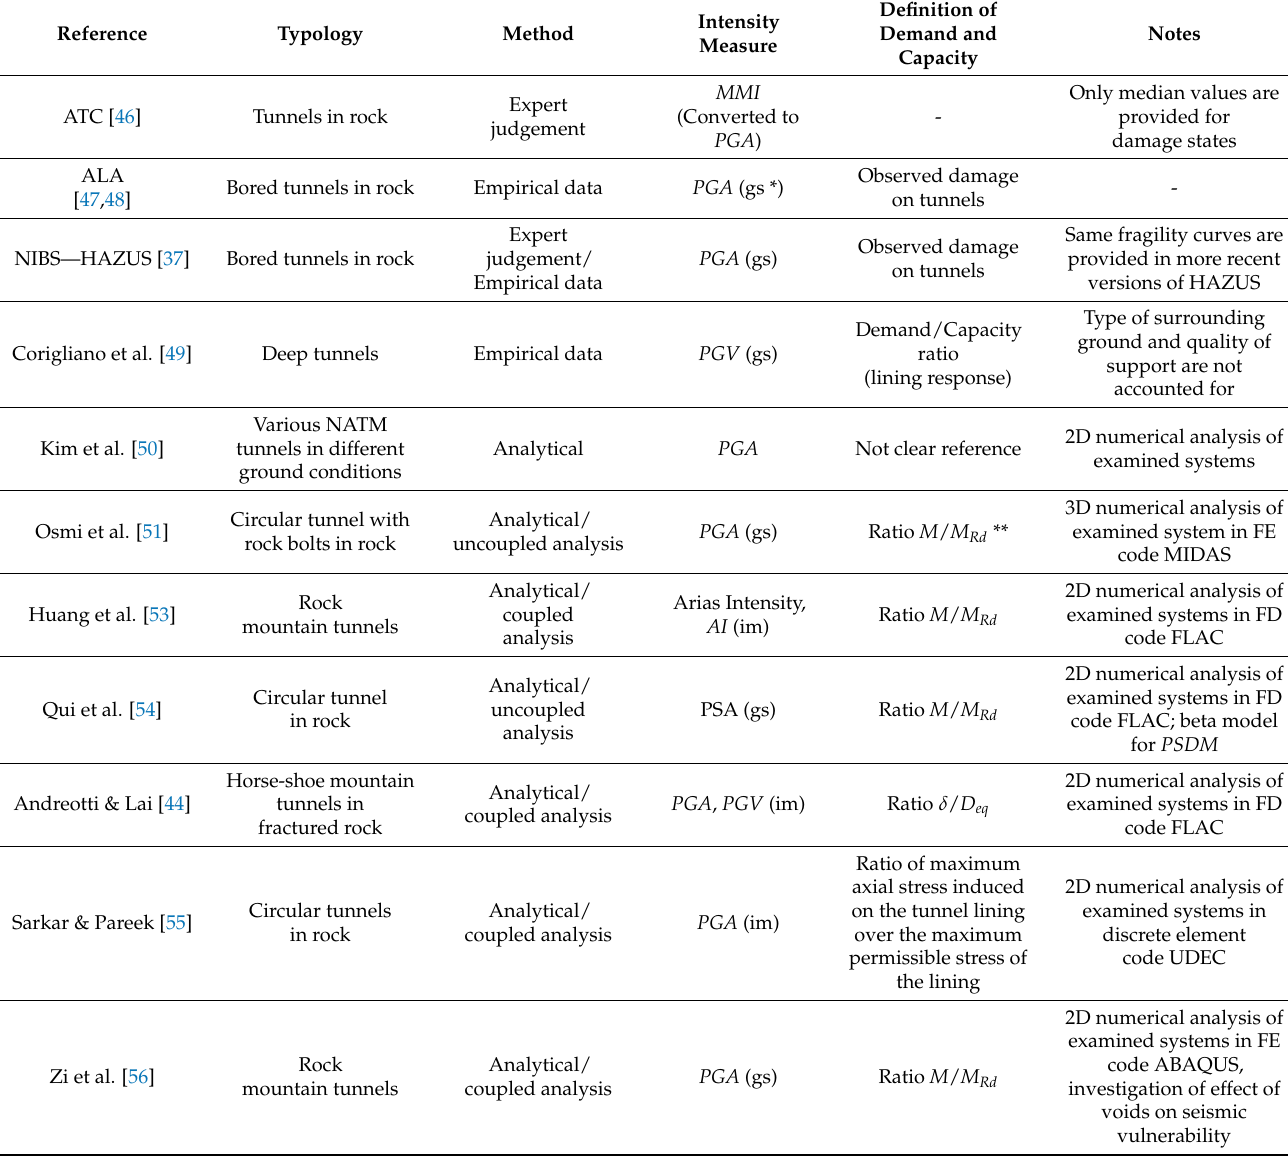
Table 1. Studies on seismic fragility assessment of mountain type tunnels or tunnels in rock subjected to ground seismic shaking in the transversal